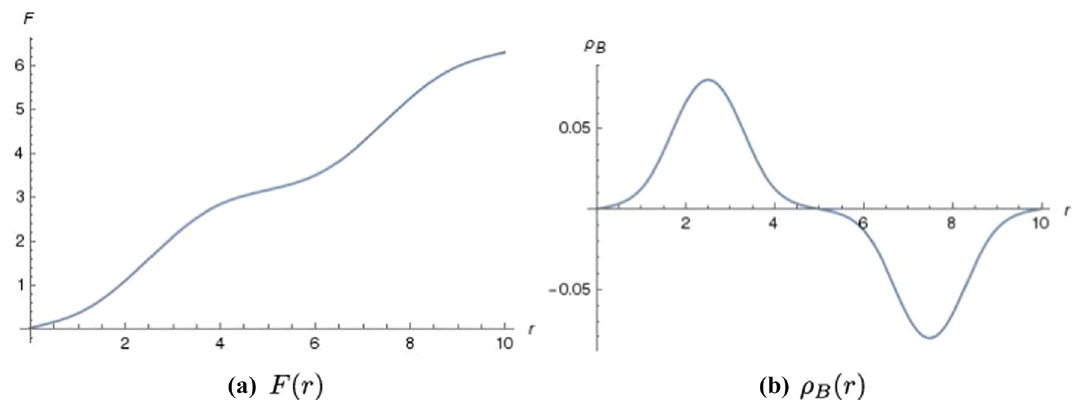
Fig. 6 Solution with m = 1 a 2 − sin 2 ( F ) 2